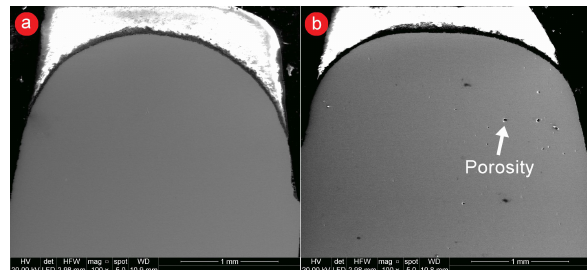
Figure 11: SEM images of metal substrate (a) drop form alloy, (b) plate form